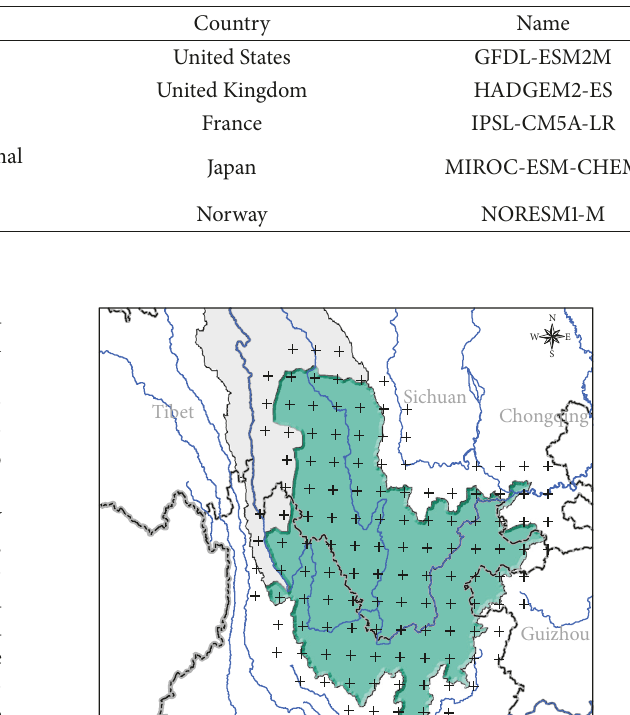
Table 1: List of general circulation models (GCMs) used in this study.